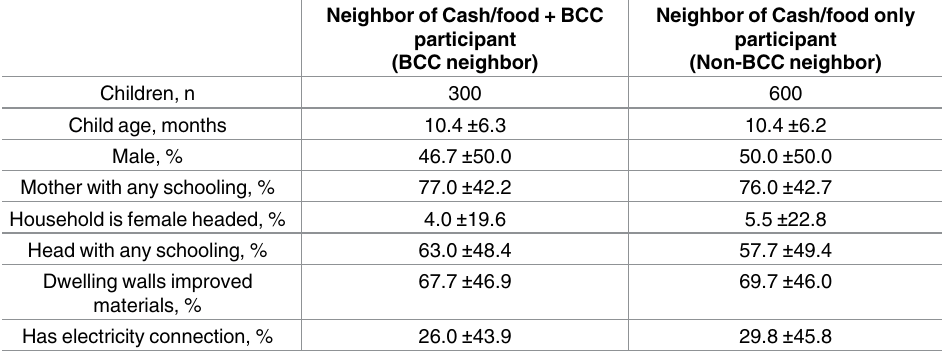
Table 1. Unadjusted mean characteristics of children, mothers and households by neighbor